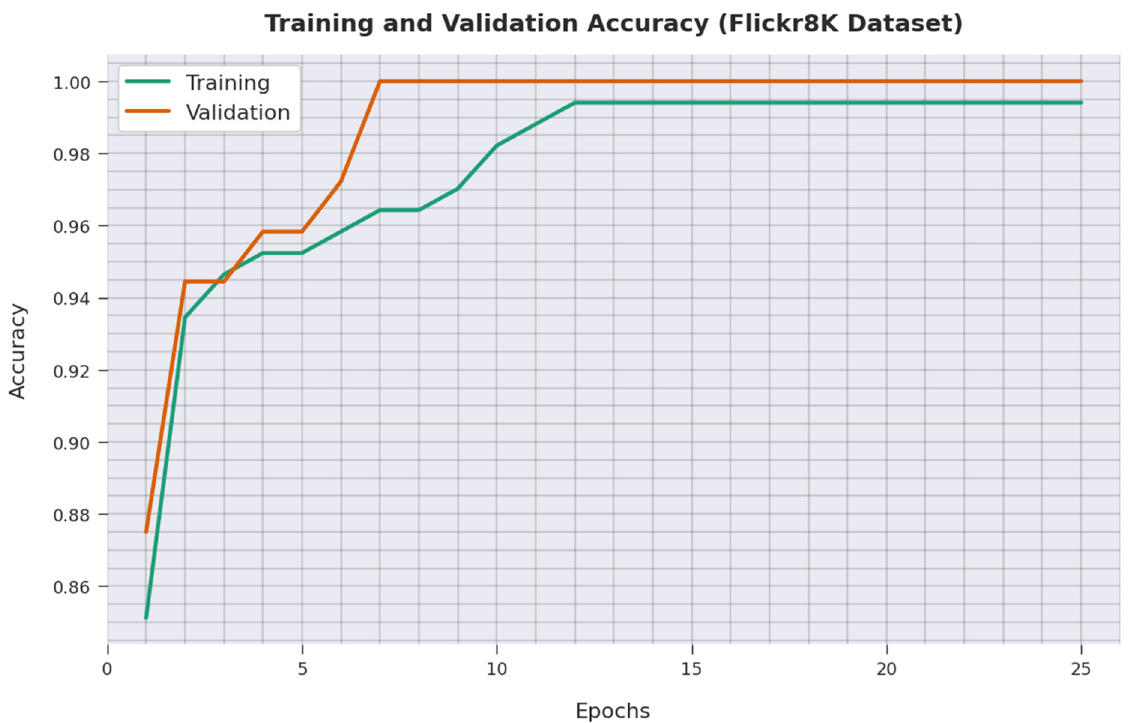
Figure 6. TA and VA analysis of MODLE-AICT technique on Flickr8K dataset.